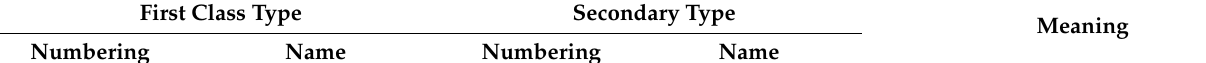
Table 1. Land-Use and Land-Cover Change classification